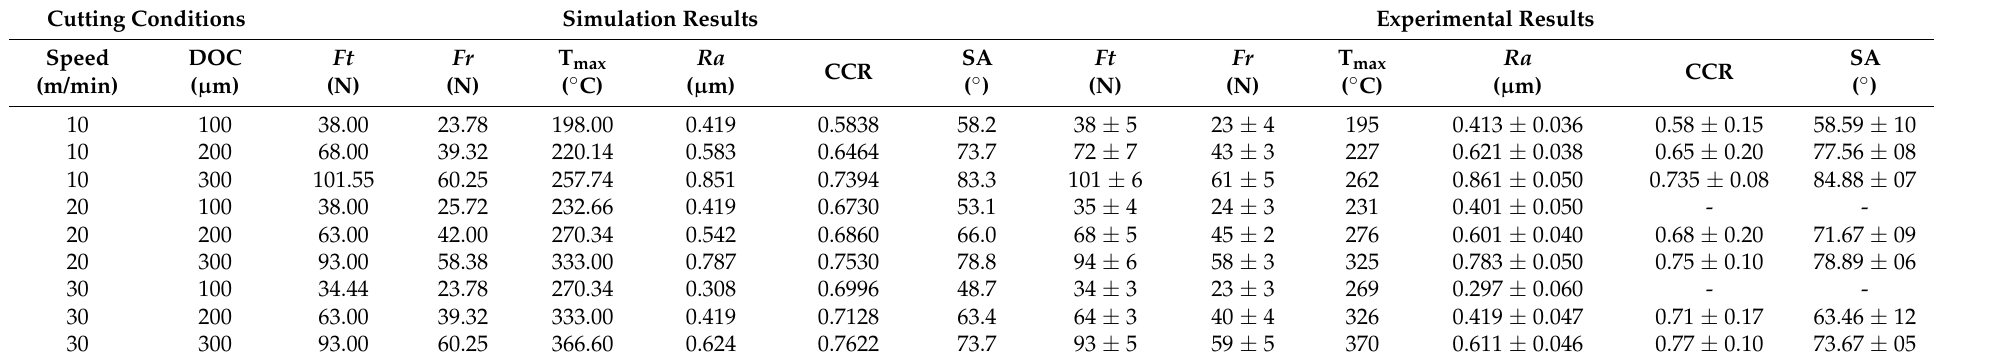
Table 6. Comparative analysis of simulation and experimental results in CT.